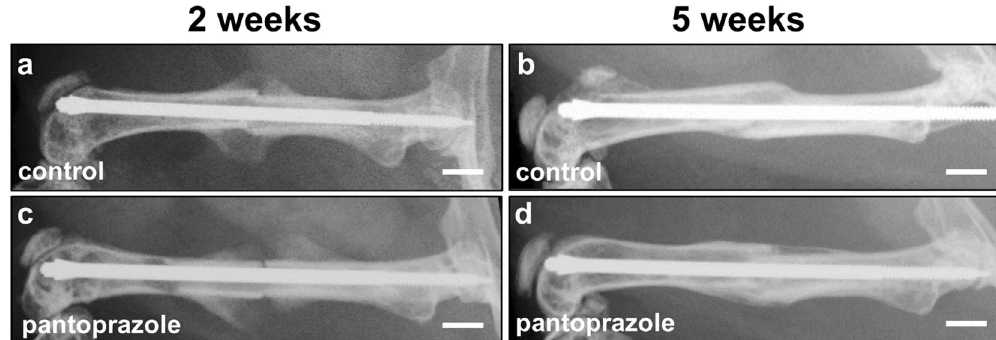
Figure 1. Radiological analysis of mice femora. Radiological images of the femora of controls ( a , b ) and pantoprazole-treated animals ( c , d ) at 2 weeks ( a , c ) and 5 weeks ( b , d ) after fracture healing. Scale bars: 2